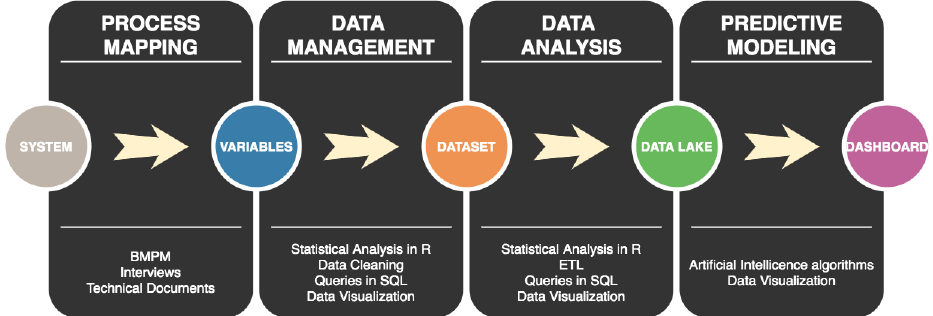
Figure 1. BAProM—Modules and techniques applied by